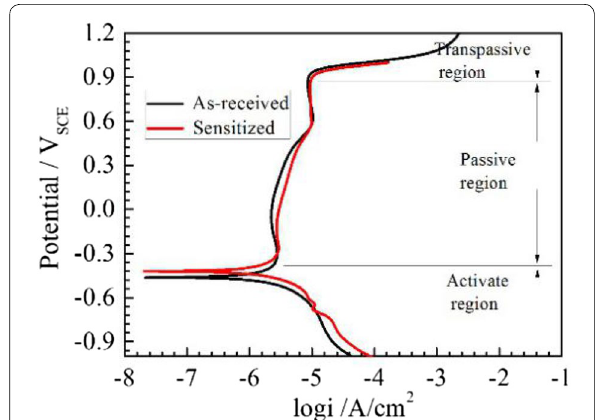
Figure 2 Potentiodynamic plots recorded for the as-received and sensitized AISI304 stainless steel in borate buffer